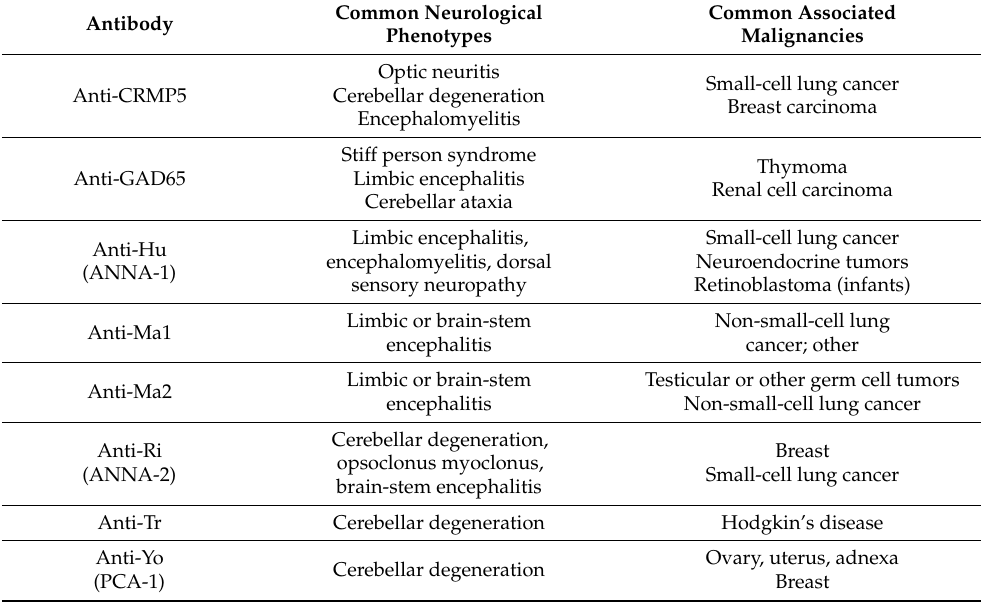
Table 3. Major paraneoplastic onconeuronal antibodies reactive with intracellular neuronal antigens. Adapted from Galli, J.; Greenlee, J. Paraneoplastic Diseases of the Central Nervous System